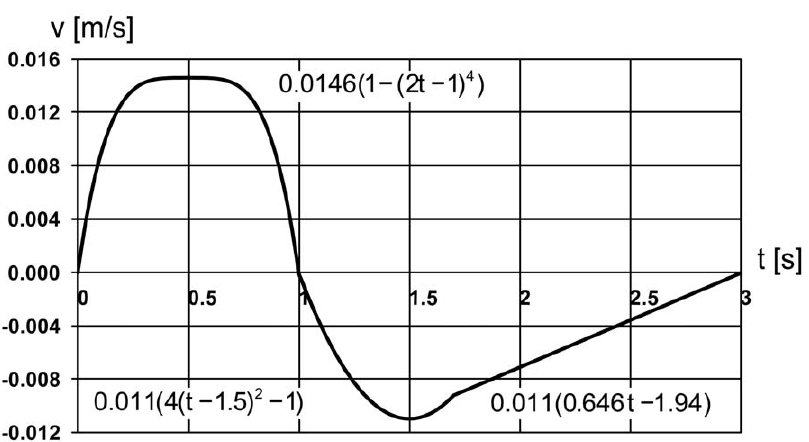
Figure 2. Graph of the moving wall velocity during the breathing cycle used in 2D CFD model.